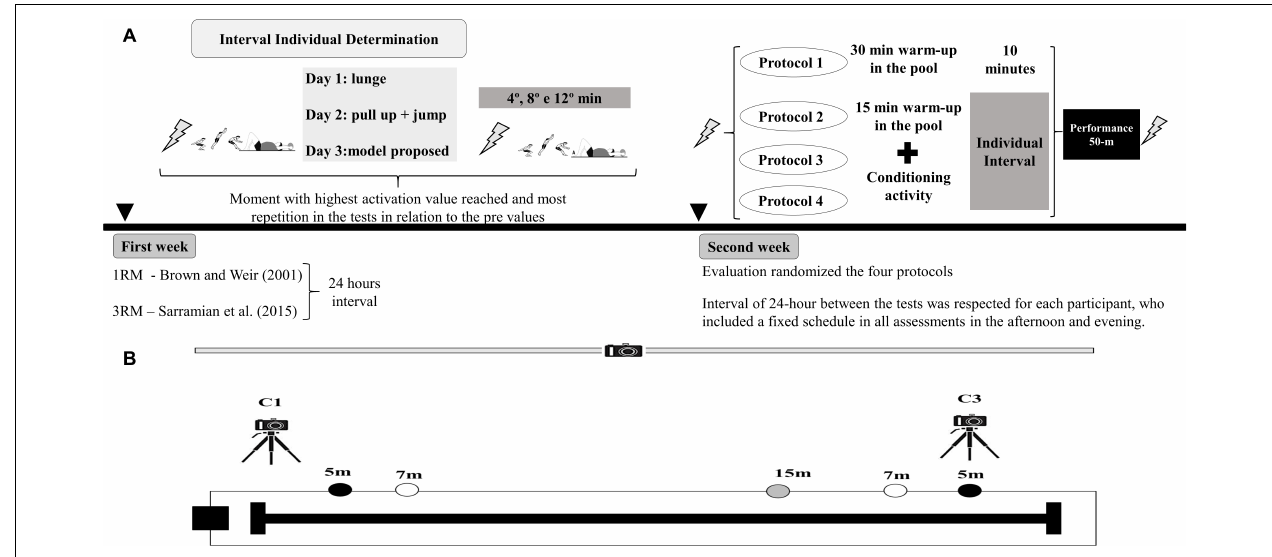
FIGURE 1 | (A) Experimental design and the timeline of the evaluations. (B) Scheme of the positioning of the cameras and markings for analysing the variables coming from the block exit (C1), clean swimming (C2) and turns (C3). 1RM: one-maximum repetition test; 3RM: three maximal repetitions. Protocol 1: standard warm-up in the pool (30 m); Protocol 2: 15 m warm-up in the pool and 1 × 3 repetitions at 85% 1RM for the lunge exercise; Protocol 3: 15 m warm-up in the poll and three maximum repetitions of pull-ups in the fixed bar and five box jumps 40 cm high and 60 cm deep wearing a vest with 10% of the body weight; Protocol 4: model proposed combining Protocol 2 and Protocol 3; Lightning symbol: Interpolation Twitch Technique.